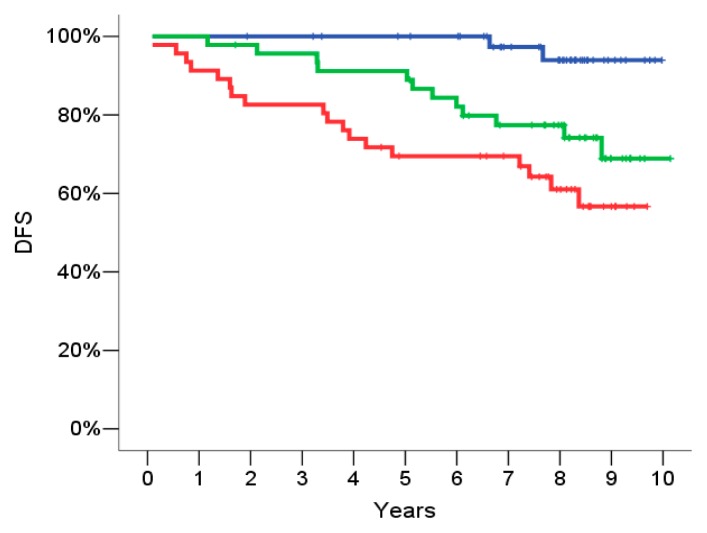
Training set: Probability of 5 years relapse: Disease free survival (DFS) according to the risk groups defined by the gene signature in the training set: Low risk group (blue curve), intermediate risk group (green curve), high risk group (red curve). The hazard ratio (HR) of DFS for intermediate risk patients as compared to low risk is 6.0 (95% Confidence Intervals (CI) = 1.35–27.0, p = 0.019 and the HR of DFS for high risk patients as compared to low risk is 10.8 (95% CI = 2.51–46.6, p = 0.001).